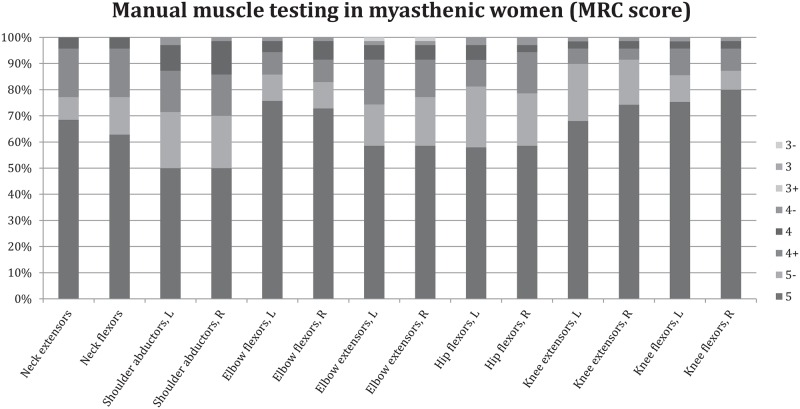
Manual muscle testing in eight muscle groups using the Medical Research Council (MRC) score in female patients with generalized myasthenia gravis.L = left side & R = right side.